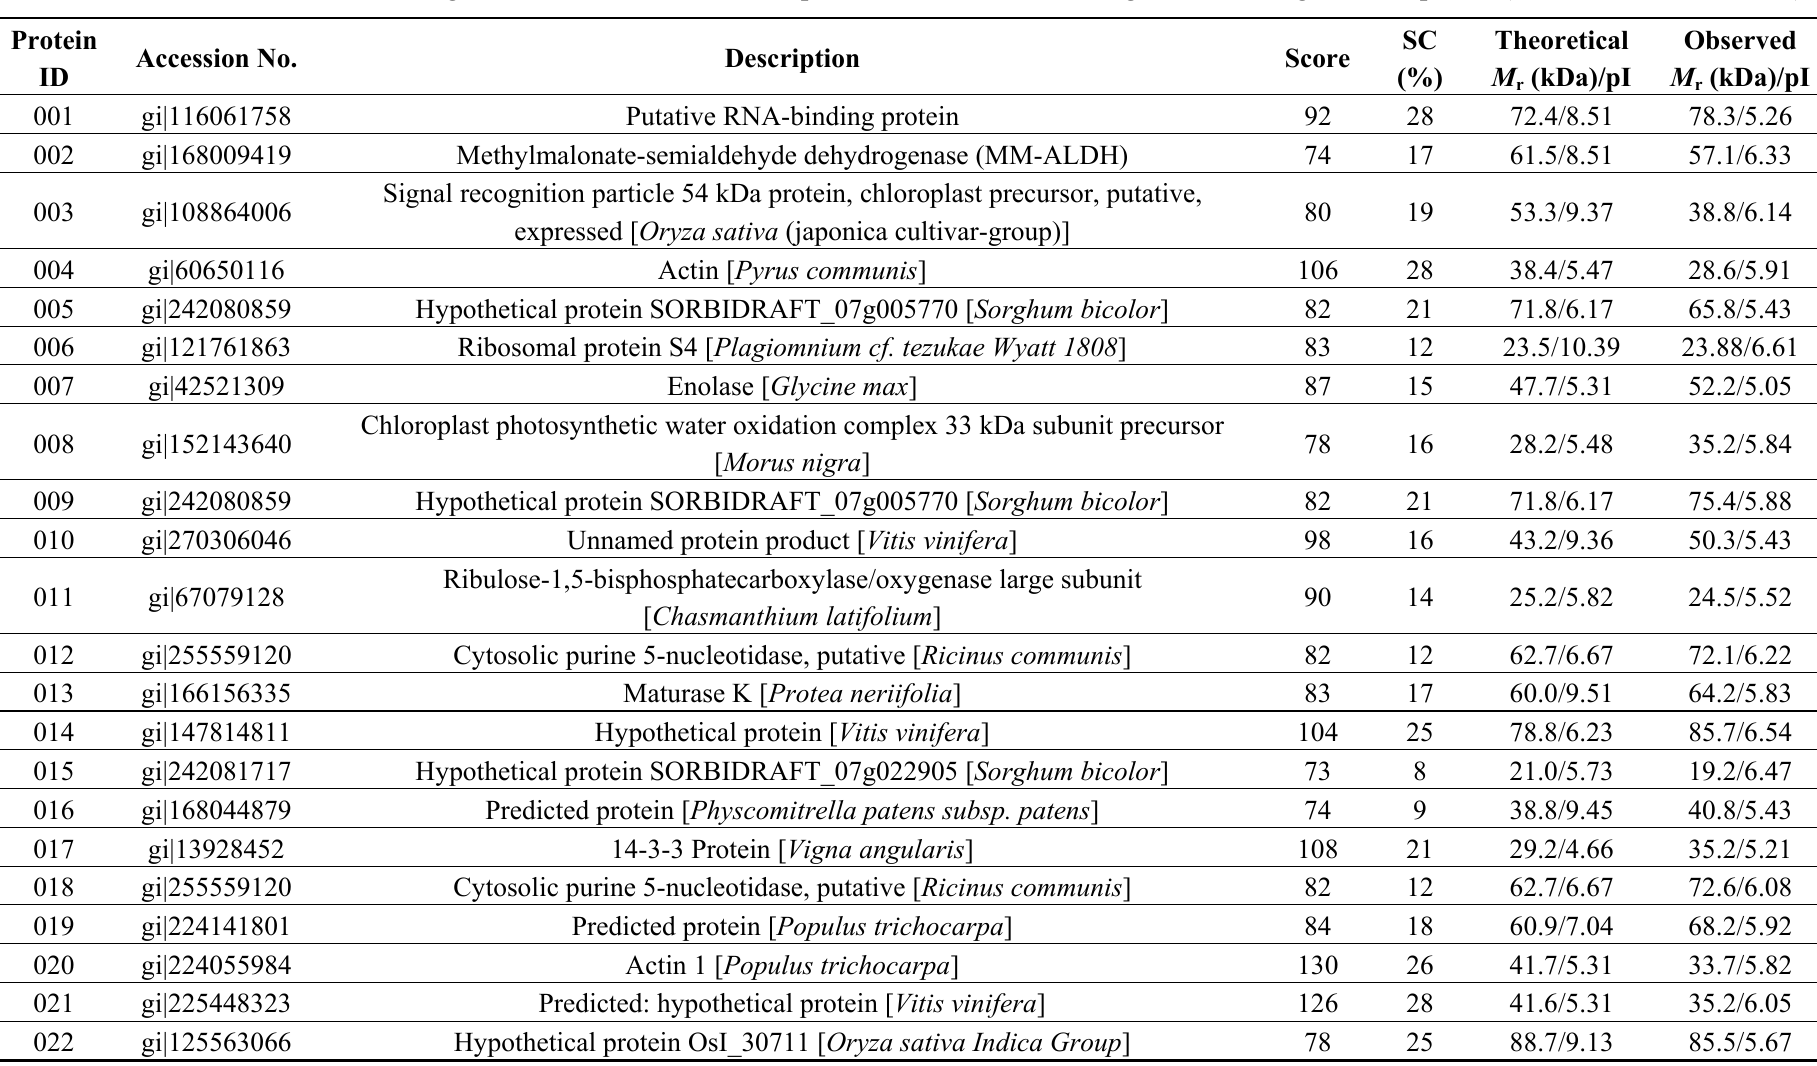
Table 1. Protein identification through matrix-assisted laser desorption/ionization time-of-flight/time-of-flight mass spectra (MALDI-TOF/TOF-MS).